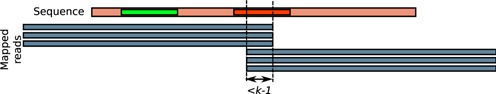
Read-coherency and k-read-coherency example. With coverage threshold = 2, schematic example where a sequence is read-coherent but not k-read-coherent. The leftmost represented k-mer (green) on the sequence is an example where the k-mer starting at this position is covered with three mapped reads. On the other hand, the rightmost represented k-mer (red) is covered by no read, thus illustrating why the sequence is not k-read-coherent.